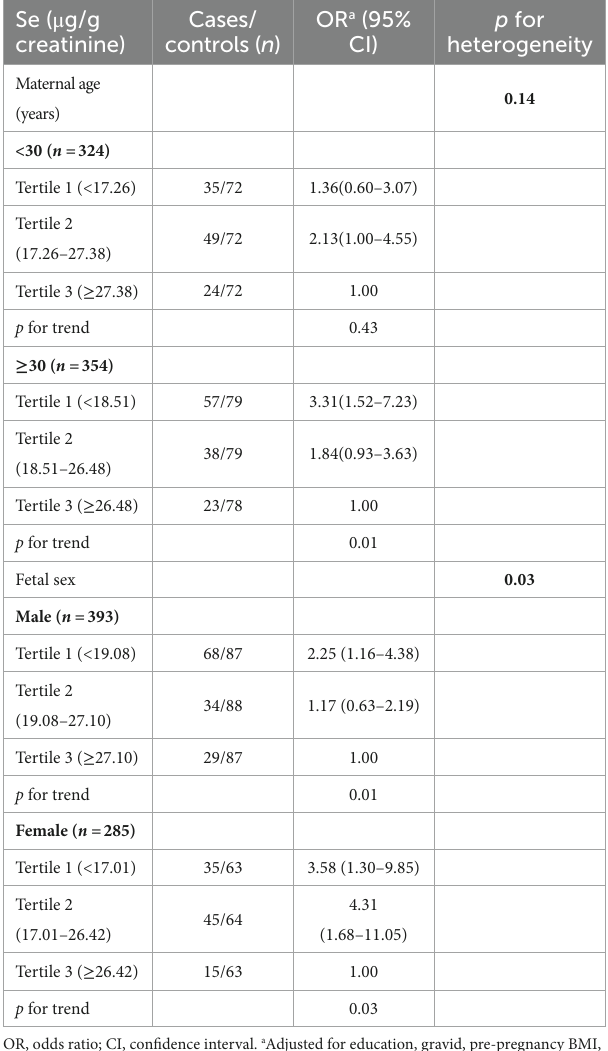
TABLE 3 The association between maternal urinary Se levels and gestational diabetes mellitus stratified by maternal age and fetal sex. Se ( μ g/g creatinine)